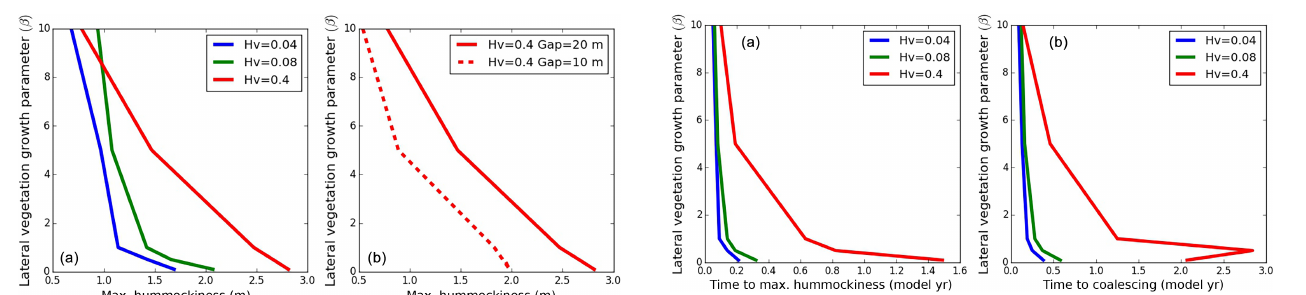
Figure 4. (a) Maximum hummockiness (m) as a function of H v (vertical vegetation growth parameter) and β (lateral vegetation growth parameter). (b) Maximum hummockiness (m) as a function of β and unvegetated dune gap size.